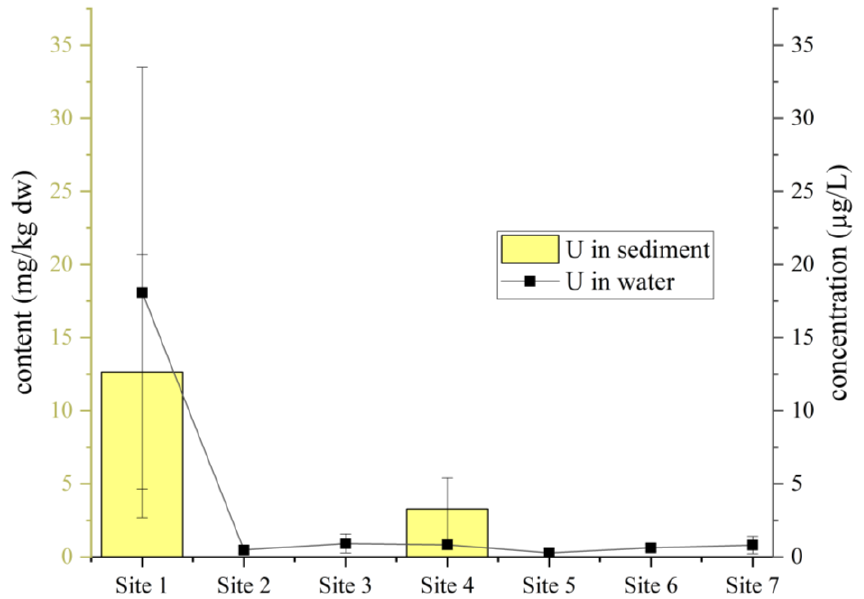
Figure 3. Mean ± SD uranium content in sediments and dissolved U concentrations in water of sampling sites along the course of mining-influenced water.